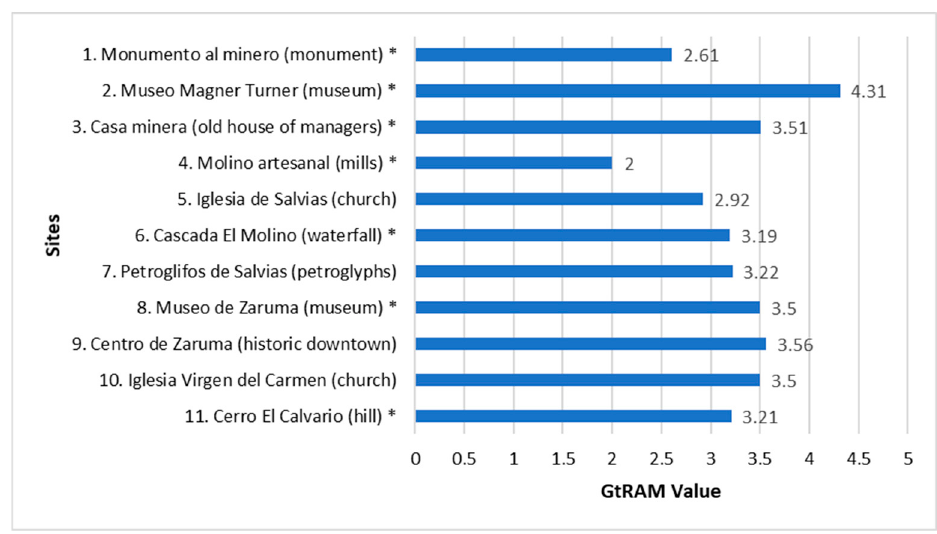
Figure 7. GtRAM evaluation of the mining sites and sites that make up the GT-I route. * Ge- osites/mining sites.